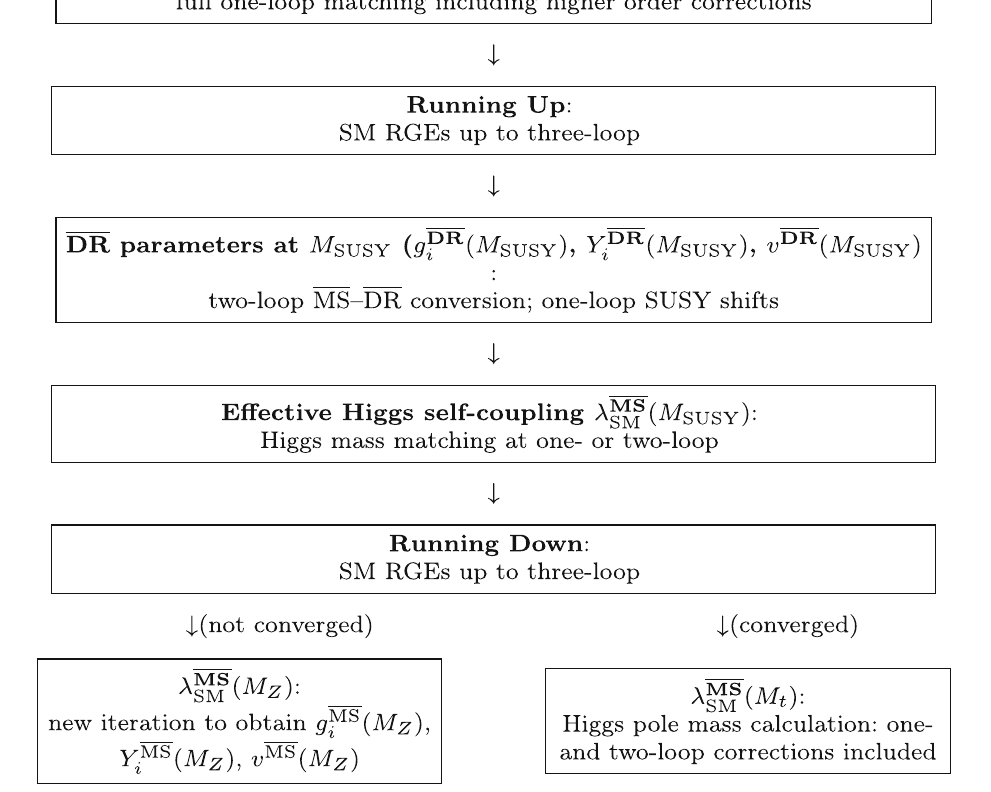
matching agrees now rather well with the SoftSUSY results once the two-loop SUSY corrections in the matching are included up to several TeV. However, for even higher SUSY scales one finds that even the SUSY calculation with two- loop thresholds gives sizeable differences to the RGE re- summed calculation. On the other side, we find an excellent agreement with FlexibleSUSY , which performs also a two-scale matching but uses a different matching procedure at the SUSY scale. 2 A similar but less pronounced effect can be seen for the bottom Yukawa coupling. Here, the changes between the one- and two-scale matching account for a shift of about 6% for a SUSY scale of 100